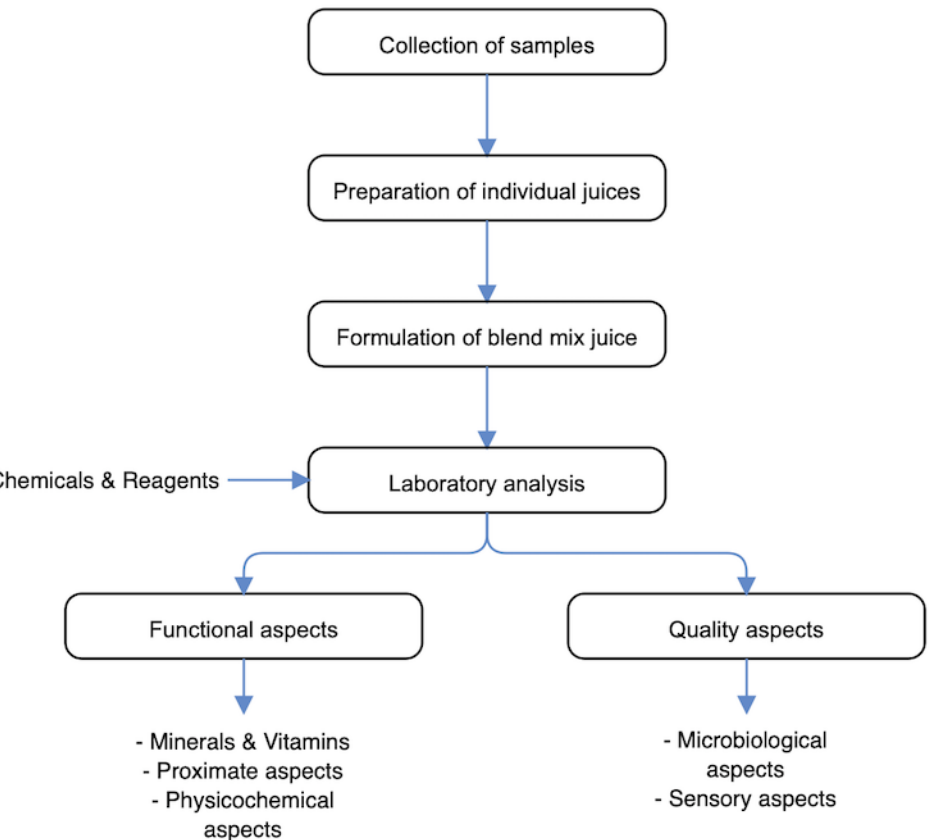
Figure 1. The schematic overview of the experimental program, depicting the essential stages from the collection of ginger, pineapple and turmeric, and preparation of individual juices, to the formulation to make the mix juice, and then, the functional and quality aspects of the laboratory analyses.